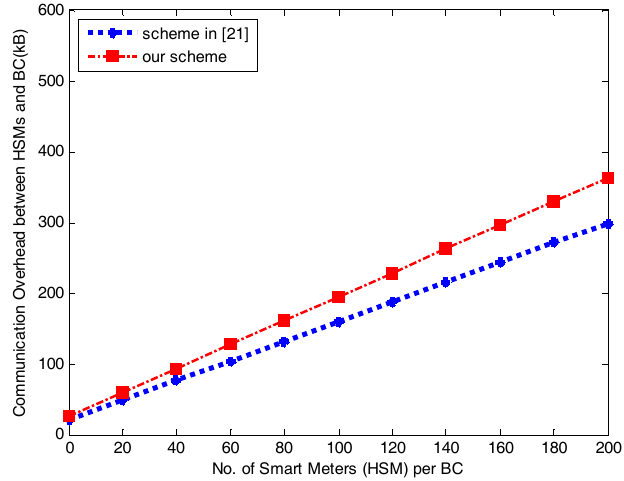
Figure 5. Communication overhead between HSM and BC in the power requirement stage.